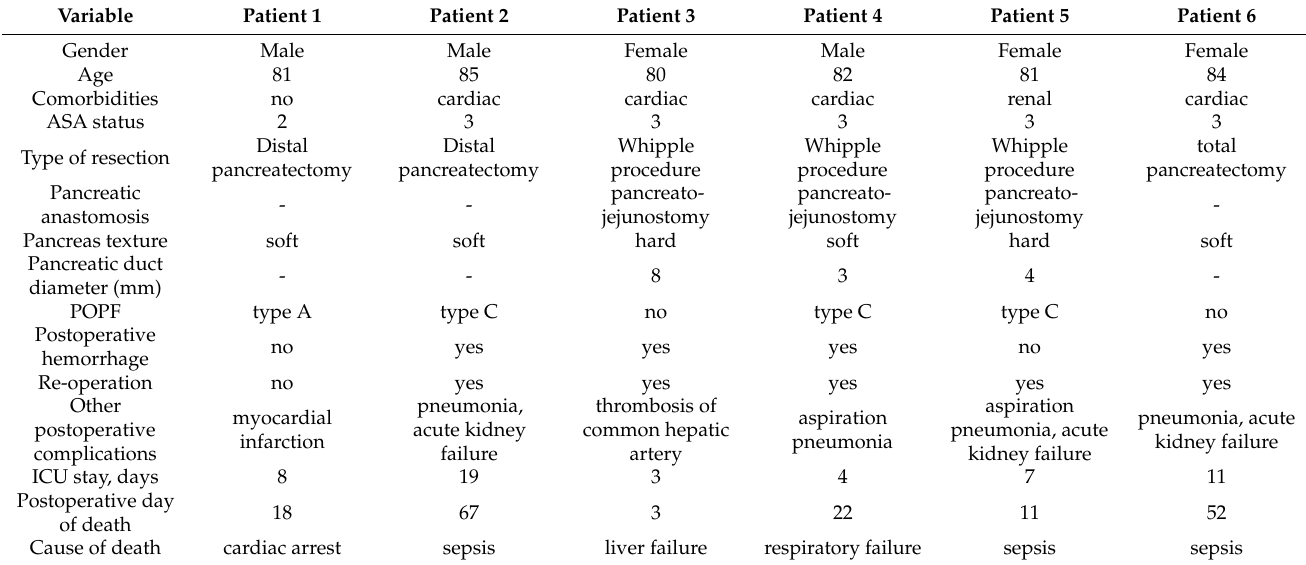
Table 5. Clinicopathological characteristics of the six patients ≥ 80 years old suffering postoperative 90-day mortality following pancreatic